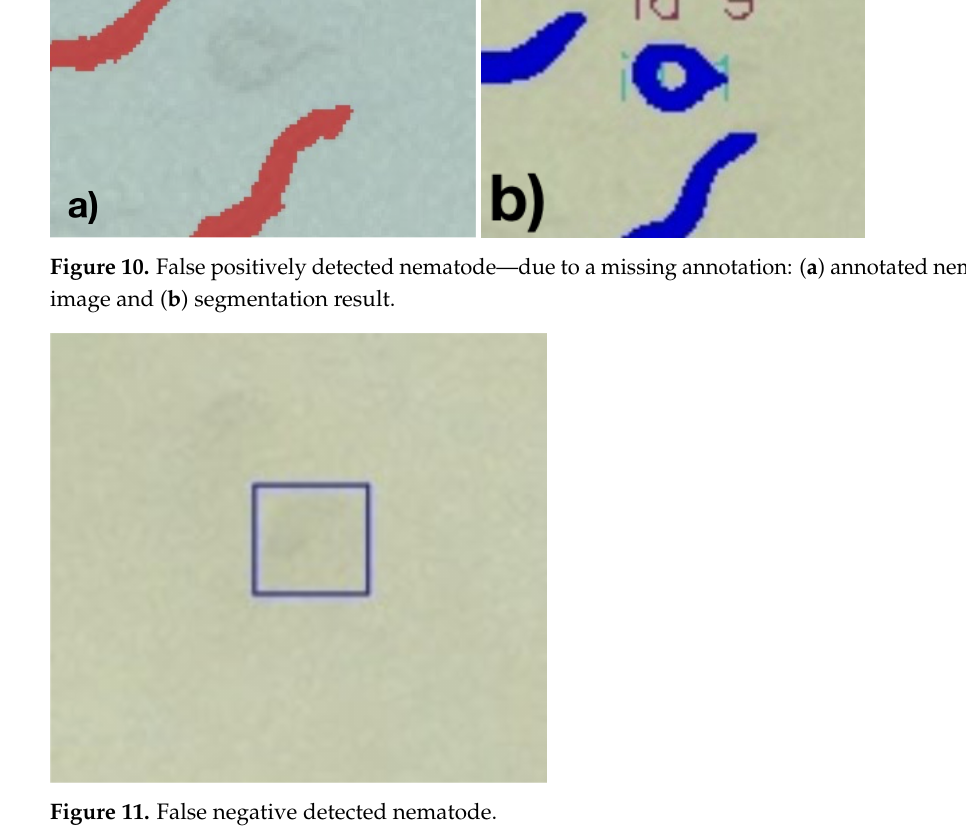
Figure 11. False negative detected nematode.